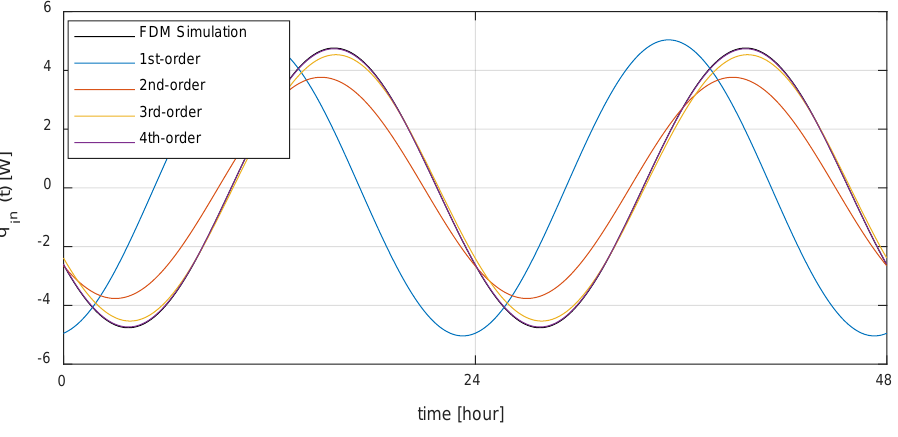
Figure 8. Step response of the models.